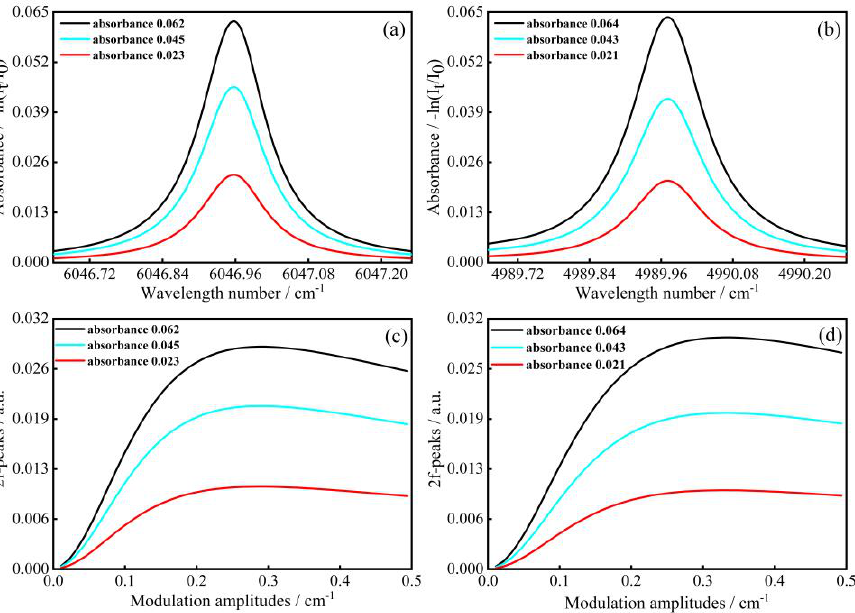
Figure 3. Different absorbance of ( a ) CH 4 and ( b ) CO 2 . 2f-peaks corresponding to different modula- tion amplitudes of ( c ) CH 4 and ( d ) CO 2 .